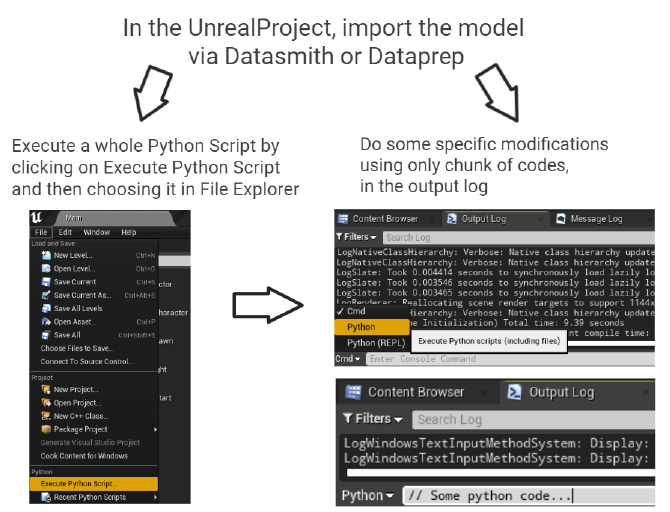
Figure 13. After import, execute Python script from files or using